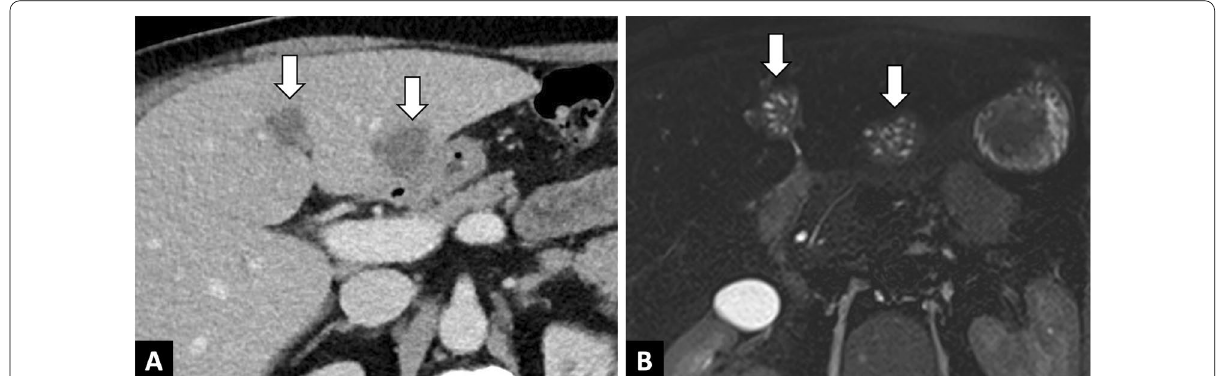
Fig. 8 Atypical CT findings of alveolar echinococcosis in a 65‑year‑old woman with a recent diagnosis of lymphoma. A CT image in the axial plane showing two aspecific hypodense liver lesions of the left liver (arrows). B T2‑weighted fat‑suppressed MR image in the axial plane showing typical microcysts within hypointense T2 lesions (arrows; Kodama